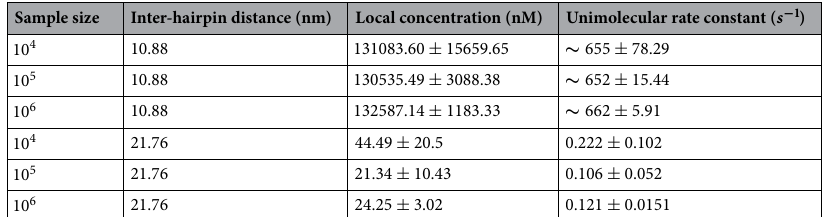
Table 2. Summary of local concentration values obtained for WN model for different sample sizes for inter- hairpin distances of 10.88 nm and 21.76 nm. A threshold distance of 2 nm between the reactive points was used to determine whether two particular structures may interact. Unimolecular rate constants were computed from multiplying the local concentration values by the bimolecular rate constant of the corresponding species if they were freely diffusing in solution. This bimolecular rate constant is the value k { 0,6 } = 5 × 10 5 M − 1 s − 1 estimated by Zhang and Winfree 17,27 , which is chosen because the system reported by Chatterjee et al. 4 employed a 6-nucleotide toehold on the invader with no distal toehold on the incumbent. Local concentration and unimolecular rate constant values are expressed as mean ± standard deviation of five sampled datasets of each